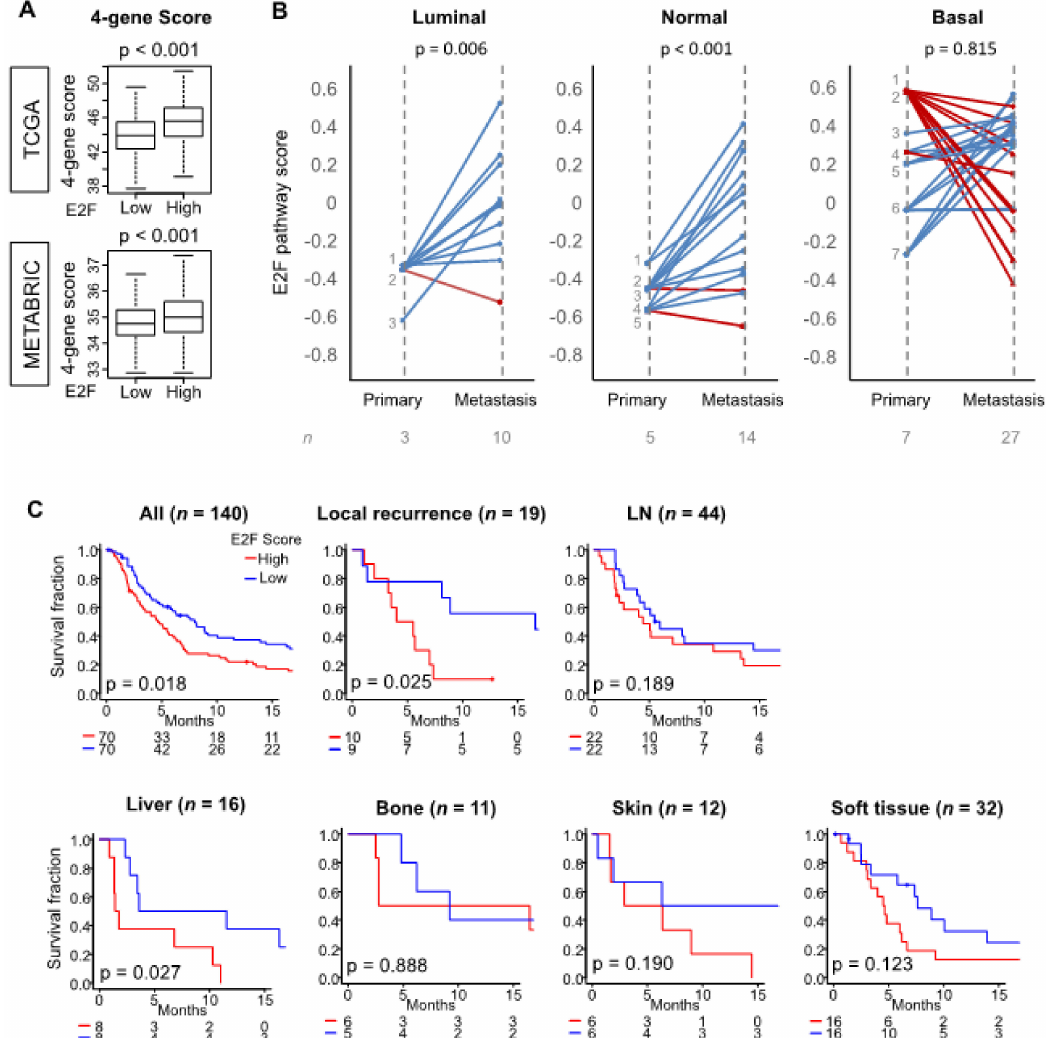
Figure 4. Association of tumor E2F pathway score with metastasis. ( A ) The 4-gene score values of tumors of high and low E2F scores of the TCGA and METABRIC cohorts. Tukey-type boxplots demonstrate median and inter-quartile level values, and p values were calculated by the ANOVA test. The 4-gene score was calculated from the tumor expression of DOK4 , HCCS , PGF , and SHCBP1 genes. ( B ) Matched comparison of E2F scores of primary tumors and their metastatic tumors for luminal, normal, and basal (PAM50 classification) types of breast cancer in the GSE110590 cohort. Cases with E2F scores greater for metastasis compared to the primary tumor are marked blue, and others are marked red. Group sizes are shown underneath the plots. p values were calculated by the paired t test. ( C ) Primary tumors with high and low E2F scores in the GSE124647 cohort of patients with distant metastasis or local recurrence ( n = 140) are compared for progression-free survival within the whole cohort as well as sub-groups of patients with only local recurrence or distant metastasis to specific sites. Kaplan–Meier survival curves are compared with logrank test. The within-cohort median value of the E2F score was used to divide patients into high and low